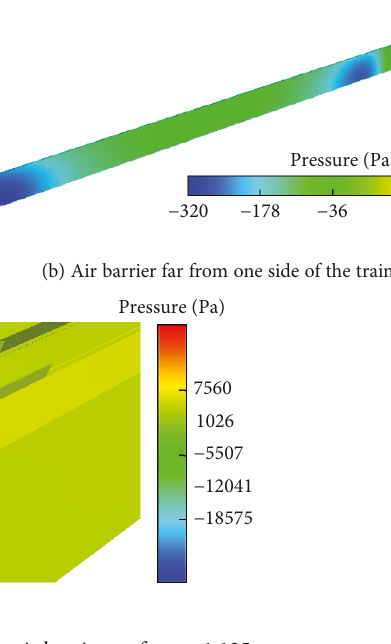
Figure 9: Contour of pressure distribution on the air barrier surface at 1.125s.